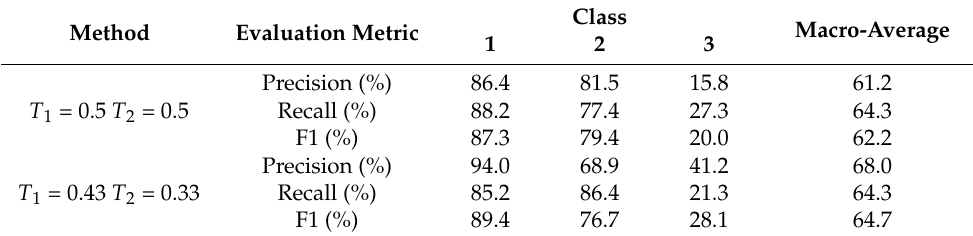
Table 8. Performance of proposed method with different thresholds.